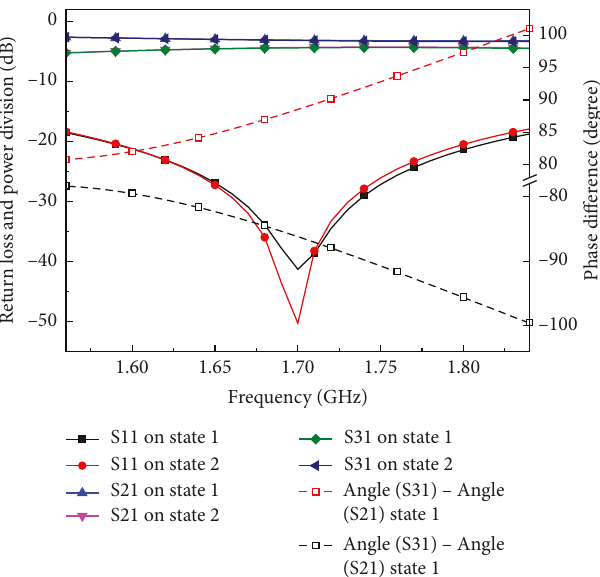
Figure 3: Simulated S parameter of the reconfigurable feeding